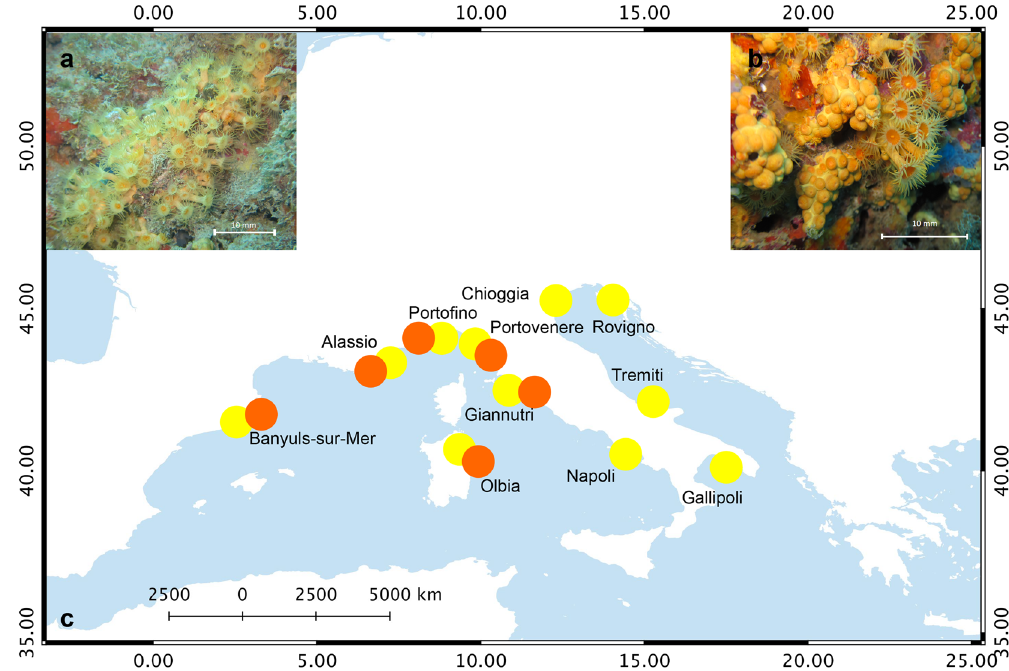
sites where the colonies of P. axinellae were collected. Yellow dots represent samples of “Slender” morphotype; orange dots represent samples of “Stocky” morphotype , The map was created with the free software QGIS (https ://qgis.osgeo .org/es/site/) and edited in Adobe Photoshop version 14.2.1 (www.adobe .com) for this